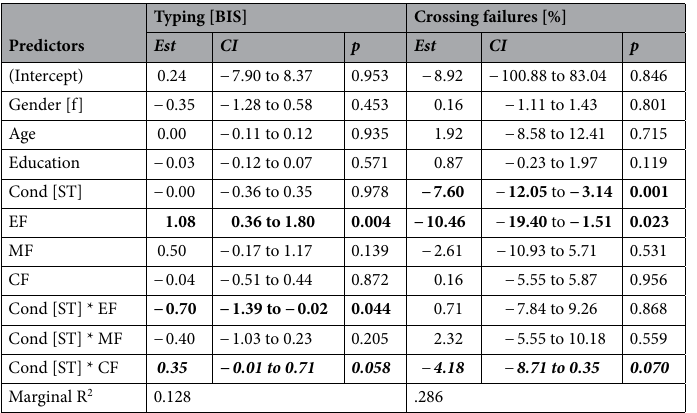
Table 1. Results of the linear mixed-effects models for typing, and crossing failures. Est estimate, CI confidence interval, Cond condition, EF executive functions, MF motor coordinative fitness, CF cardiovascular fitness, ST single-task, MT multitask. Significant effects ( alpha < 0.05) are written in bold and marginal significant effects ( alpha ≥ 0.05 and < 0.10) are written in bold and italic.